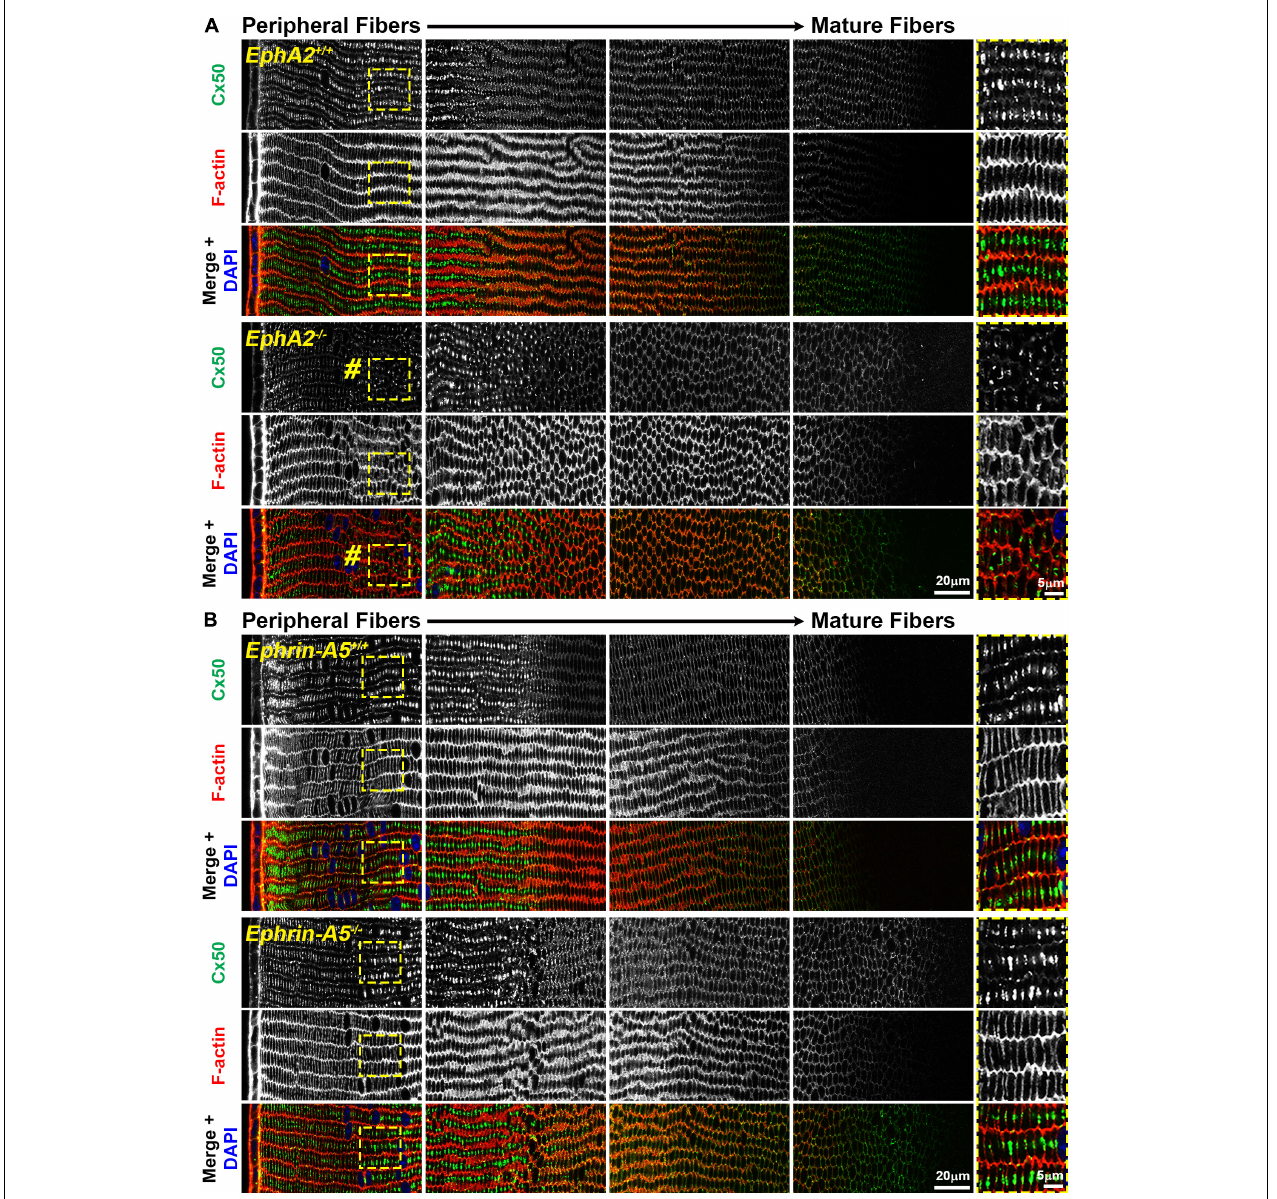
FIGURE 2 | Connexin 50 (Cx50, green) and phalloidin (F-actin, red) staining in cross sections from control, EphA2 − / − and ephrin-A5 − / − lenses. Images are from the periphery to the inner mature fiber cells of the lens. (A) In control lens fibers, Cx50 is present at the cell membrane of peripheral cells and enriched in large plaques in the middle of the long sides of those cells. As fiber cells mature, Cx50 is distributed around the cell membrane with slight enrichment at the short sides. Unexpectedly, in EphA2 − / − peripheral lens fibers, there is a distinct region where the Cx50 signal is reduced at the cell membrane and is no longer in large plaques in the middle of the long side of the fibers (pound signs and high magnification panels on the right). As the cells mature, the Cx50 signal in EphA2 − / − fiber cells is comparable to the control. (B) Cx50 staining signals are comparable between control and ephrin-A5 − / − lens fibers in the peripheral and mature fibers. Scale bars, 20 and 5 µ